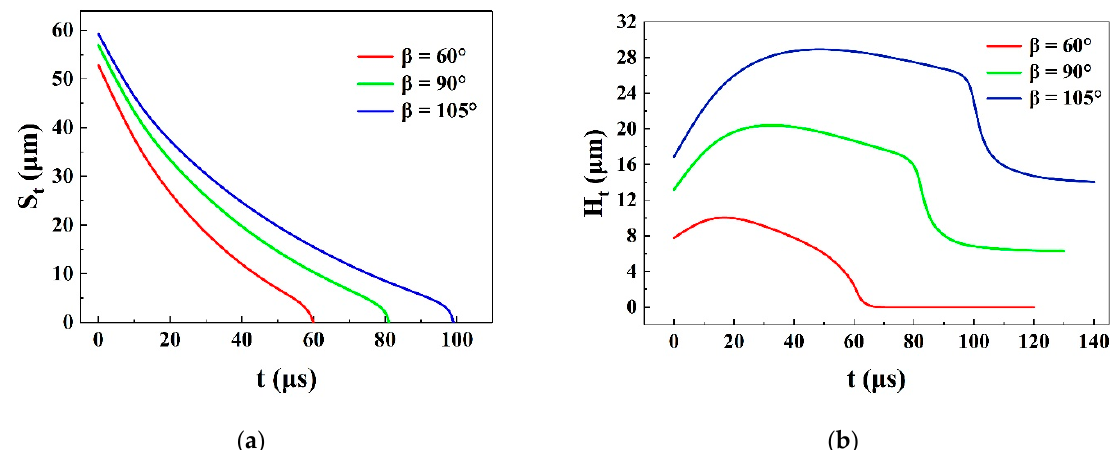
Figure 8. The change trend of ( a ) the thickness of the thinnest part of the liquid filament and ( b ) the depth of the contact line on the side wall of the cell with time.